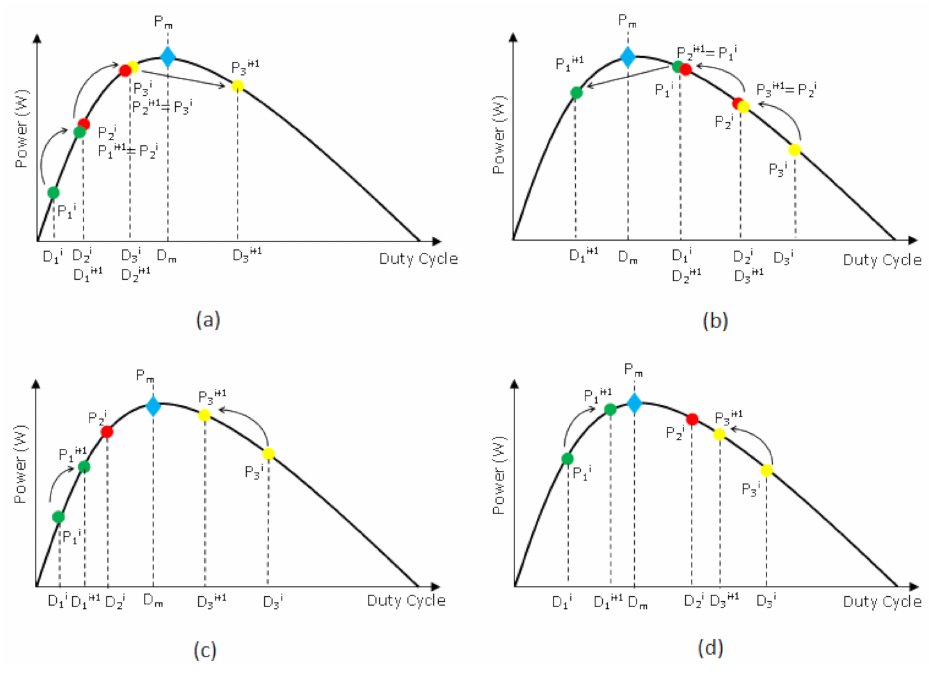
Figure 5. Illustration of algorithm ( a ) case 1 ( b ) case 2 ( c ) and ( d ) case